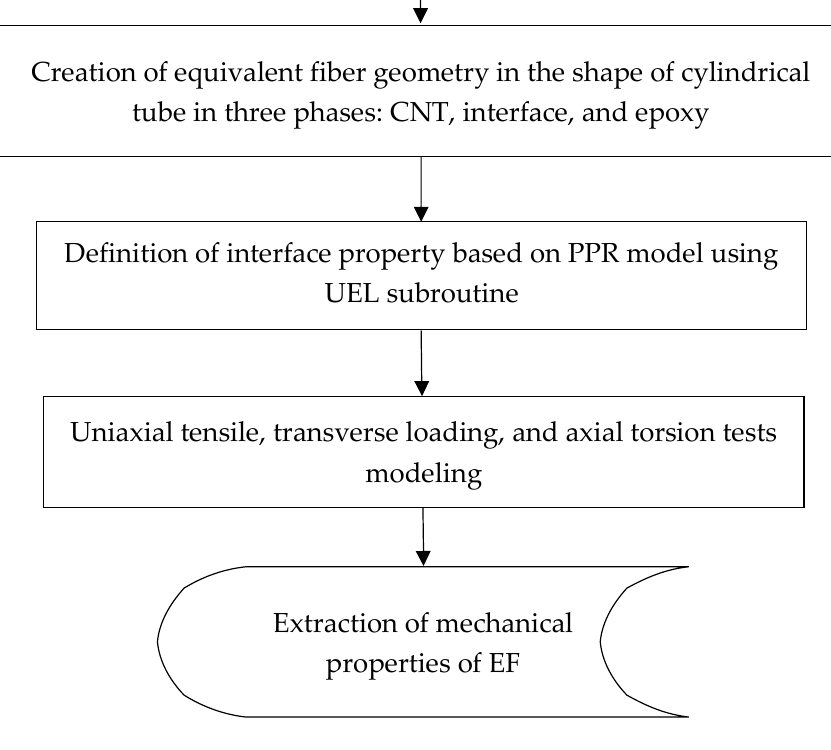
Figure 6. Modeling steps at the nanoscale.